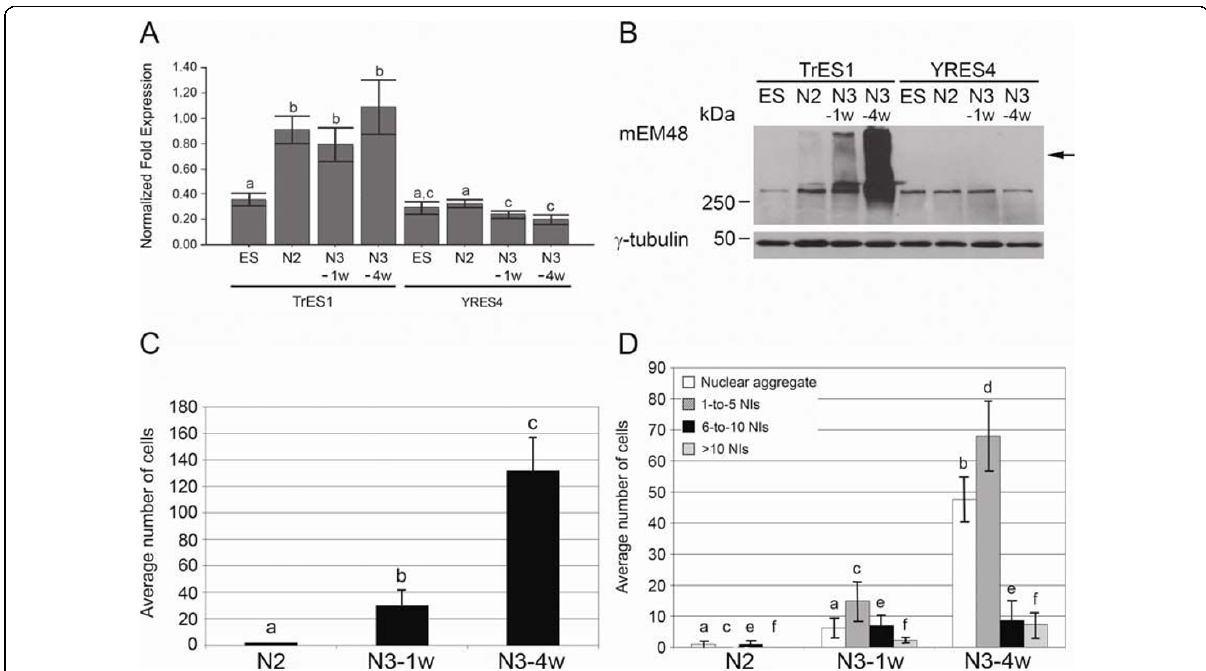
Figure 4 Expression pattern of mutant htt in neural differentiated TrES1 . (A) Expression levels of mutant htt at various developmental stages were determined by Q-PCR. YRES4 is a WT-monkey ES cell line and was used as a control. The expression levels of mutant htt in differentiated TrES1 were significantly increased at N2, N3-1w and N3-4w compared to undifferentiated TrES1 (ES) and YRES4 at all differentiation stages. Columns with the same letter indicate no significant difference (P > 0.05). (B) Western blot analysis using mEM48 revealed a gradual increase of oligomeric transgenic mutant htt as TrES1 progresses during neural differentiation (N3-4w > N3-1w > N2) whereas no high molecular weight mutant htt aggregates was detected in undifferentiated TrES1 or YRES4 at all stages. (C) Increase of cells expressing mutant htt detected by mEM48 was observed as differentiation progresses. Columns with the same letter indicate no significant difference (P > 0.05). (D) Expression pattern of mutant htt was categorized into four groups: soluble form, 1-to-5 nuclear inclusions (NIs), six to10 NIs, and more than 10 NIs. Columns of the same category with the same letter indicate no significant different (P >